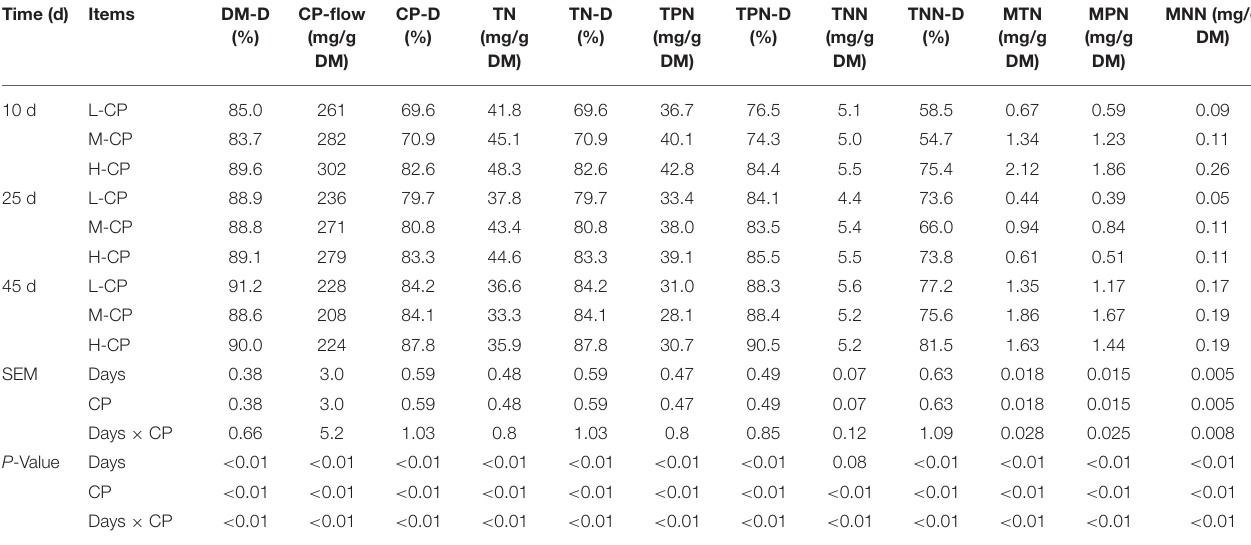
TABLE 2 | Effects of dietary different protein levels on N excretion in feces and its apparent digestibility of piglets. Time (d) Items